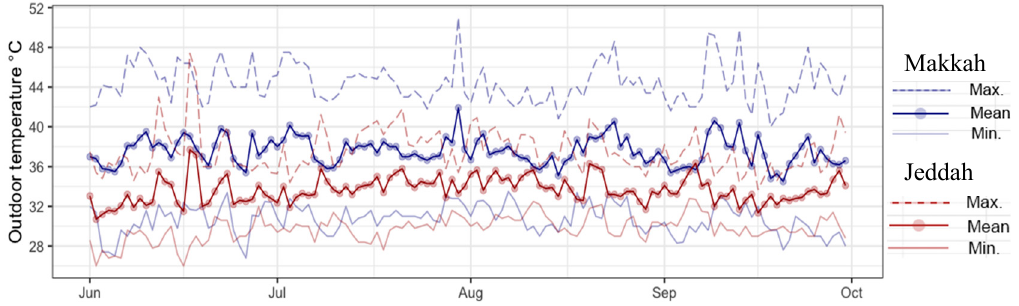
Figure 1. Daily (maximum, minimum, and mean) outdoor temperatures for Jeddah and Makkah in 2018.